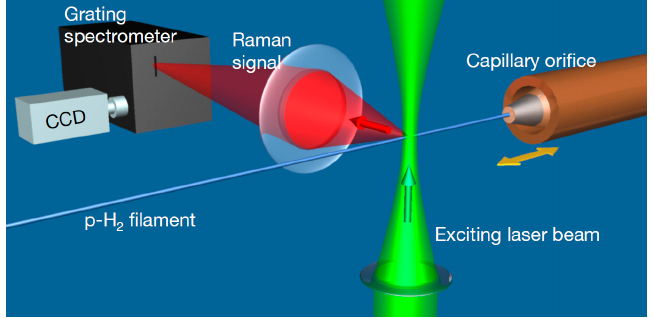
Figure 27. Schematic view of the experimental setup for Raman spectroscopy of liquid microjets used by Kühnel et